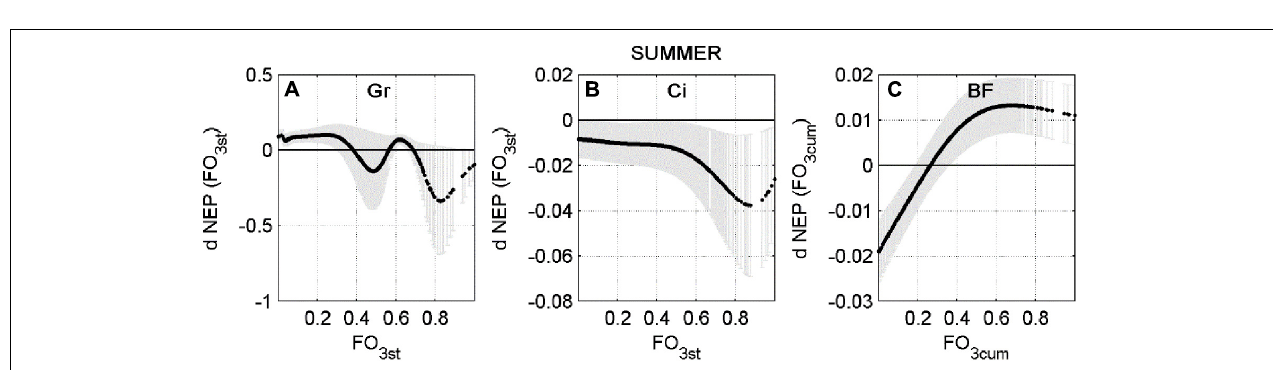
FIGURE 2 | Averaged partial derivative of NEP (dNEP) with respect to the corresponding input variable (FO 3st or FO 3CUM ) ± standard deviation, calculated using Spring data. (A) Auchencorth Moss (Au), (B) Bugac (Bu), (C) Castelporziano (CPZ), (D) Bosco Fontana (BF), (E) Blodgett (BL), (F) Lindcove (Ci).